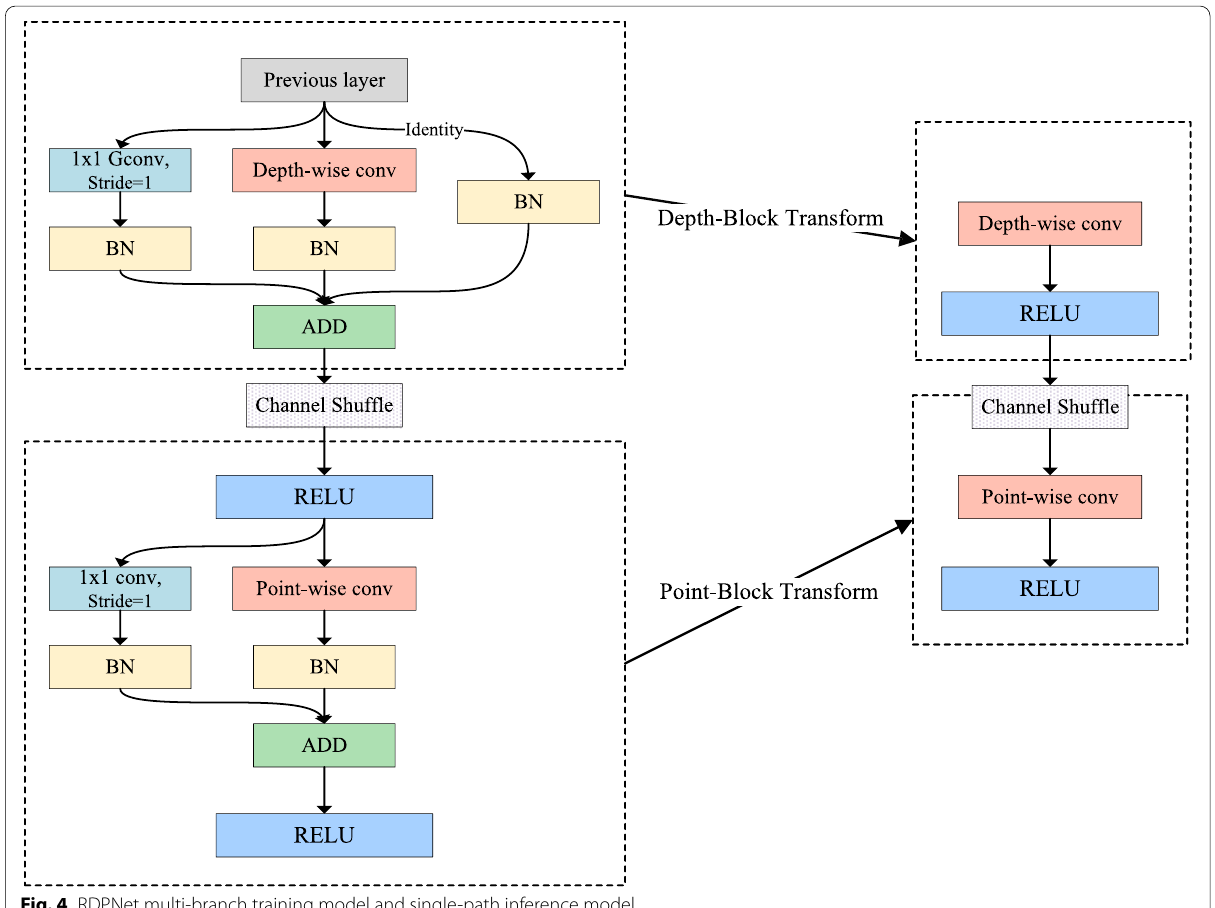
Fig. 4 RDPNet multi-branch training model and single-path inference